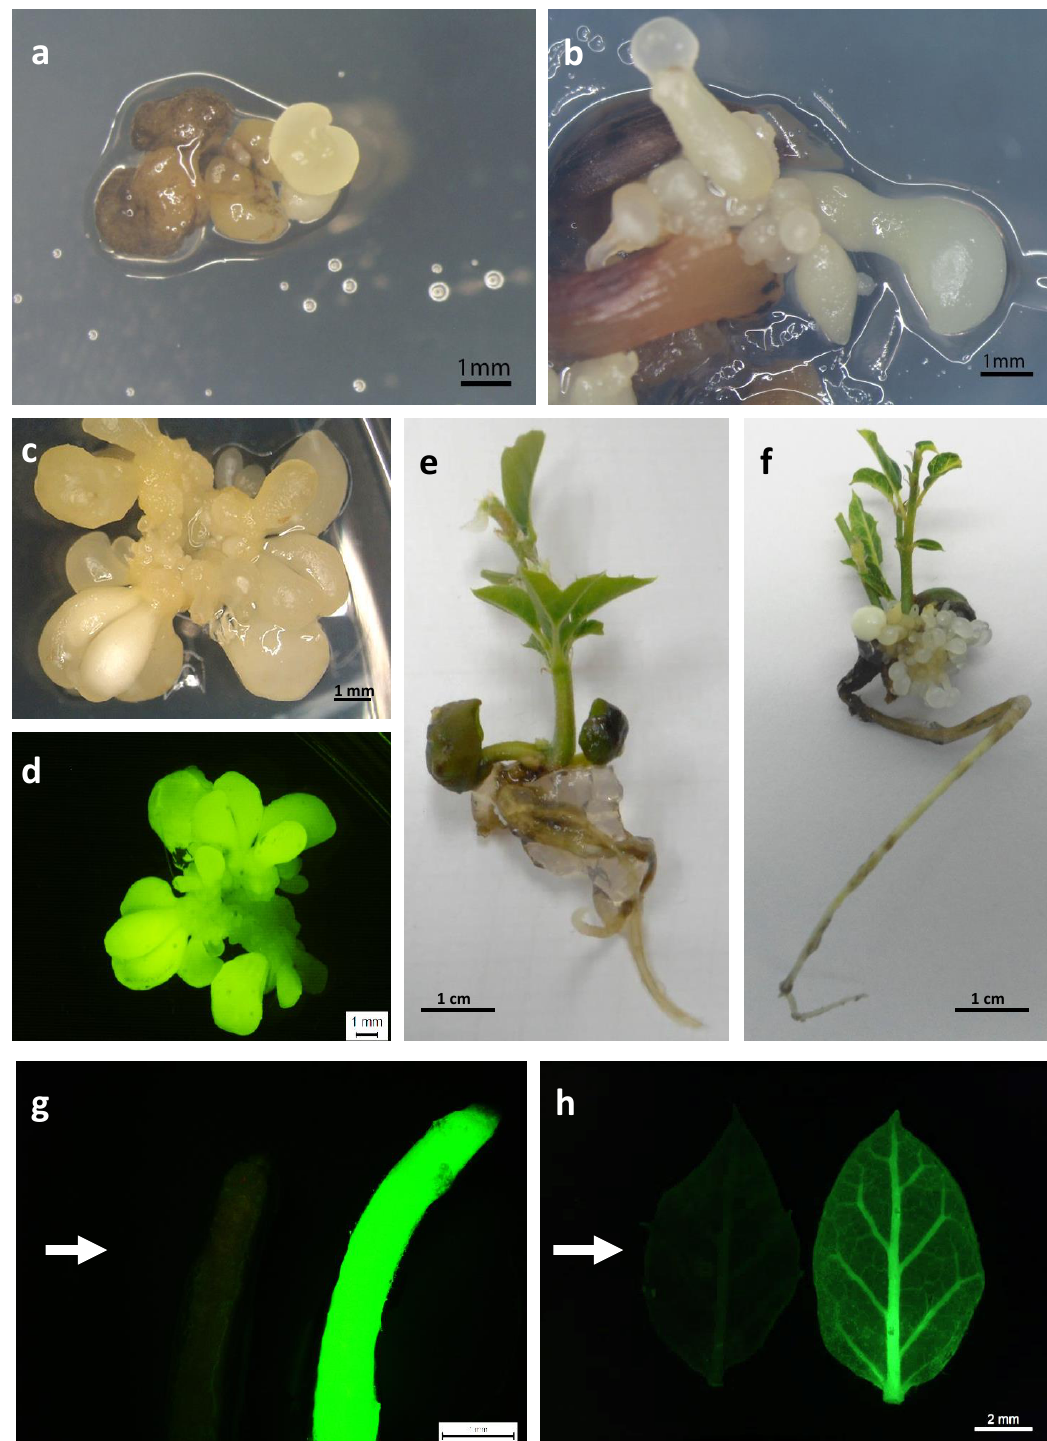
Figure 3. Different steps in the production of transgenic somatic embryos and transgenic cork oak plantlets. ( a , b ) Kan- resistant somatic embryos derived from genetic transformation of cork oak embryogenic genotypes ALM80 ( a ) and ALM6 ( b ) observed after 10 weeks in selective medium; ( c , d ) Transgenic cluster of somatic embryos visualized under white light ( c ) and green fluorescence protein ( GFP ) filter ( d ); ( e , f ) Plantlets obtained from germination of non-transgenic ( e ) and transgenic ( f ) somatic embryos after 6 weeks on germination medium; ( g ) GFP expression on a root of non-transgenic (left; arrow) and transgenic (right) plantlets, visualized in an epi-fluorescence stereomicroscope; ( h ) GFP expression on a leaf isolated from non-transgenic (left; arrow) and transgenic (right) plantlets visualized in an epi-fluorescence